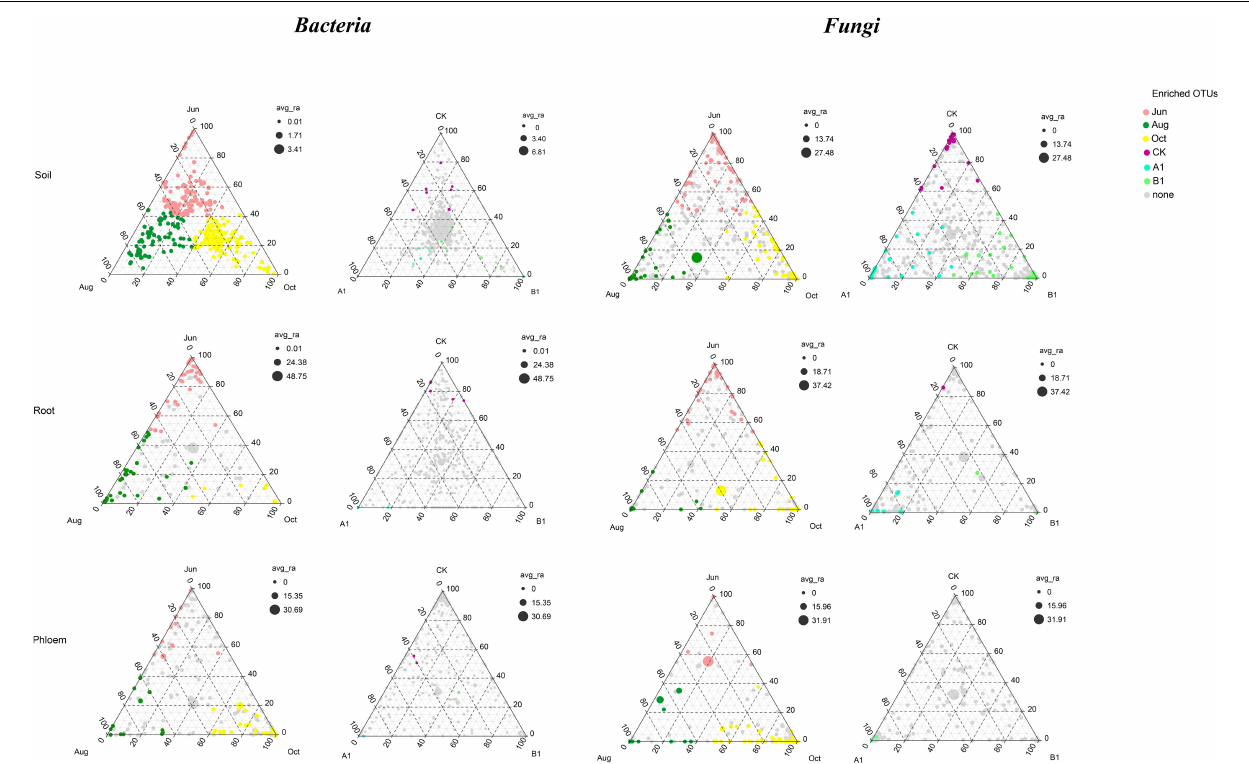
FIGURE 7 | Ternary plot depicting the relative abundances of all OTUs for bacterial and fungal communities across the three habitat classifications (soil, roots, and stems), seasons (June, August, and October), and genotypes (CK, A1, and B1). Each point corresponds to an OTU, its position represents its relative abundance with respect to each group, and its size represents the average across all three groups. Colored circles represent OTUs enriched in one group compared to the